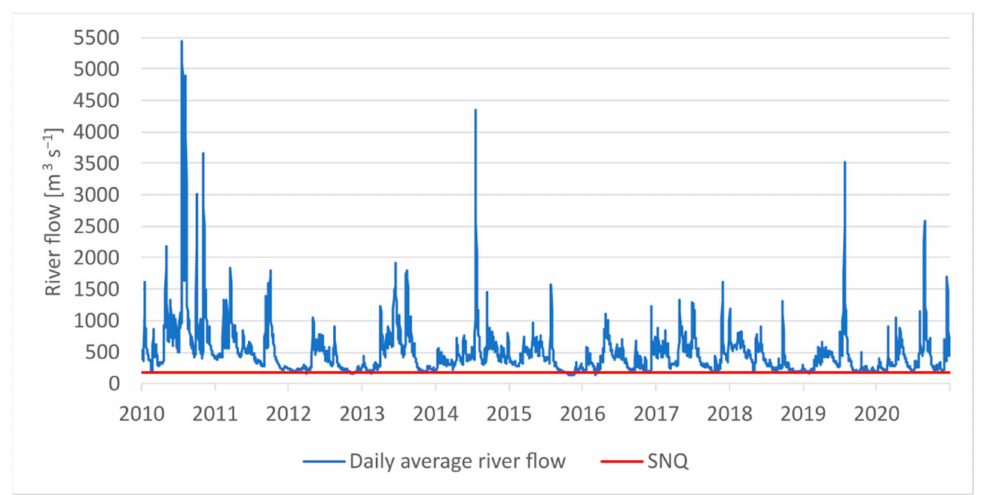
Figure 7. The flow of the Wisła River at the location of the D˛eblin water gauge station in the hydrological years 2010–2020.